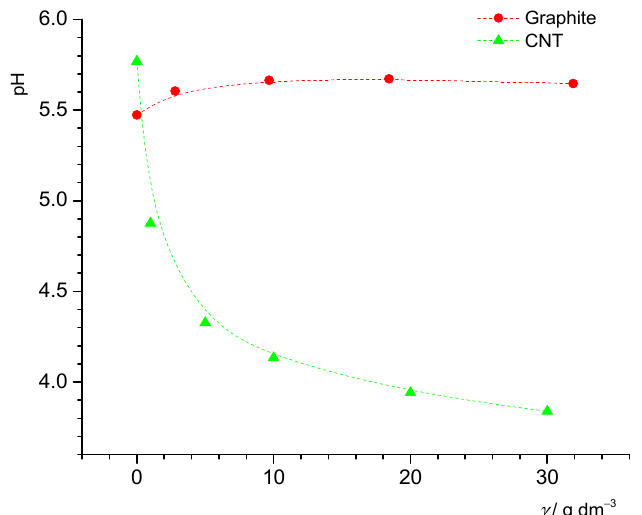
Figure 4. Potentiometric mass titration of graphite and CNT in NaCl(aq) solution. I c = 2 mmol dm − 3 , θ = 25 °C.